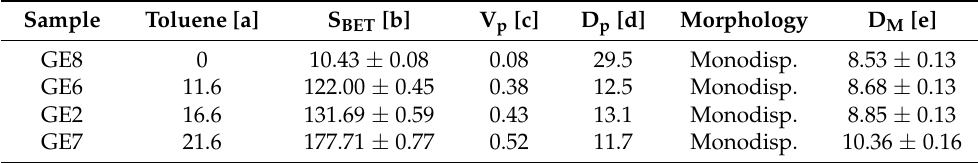
Table 3. Effect of porogen amount on morphology and porous structure.